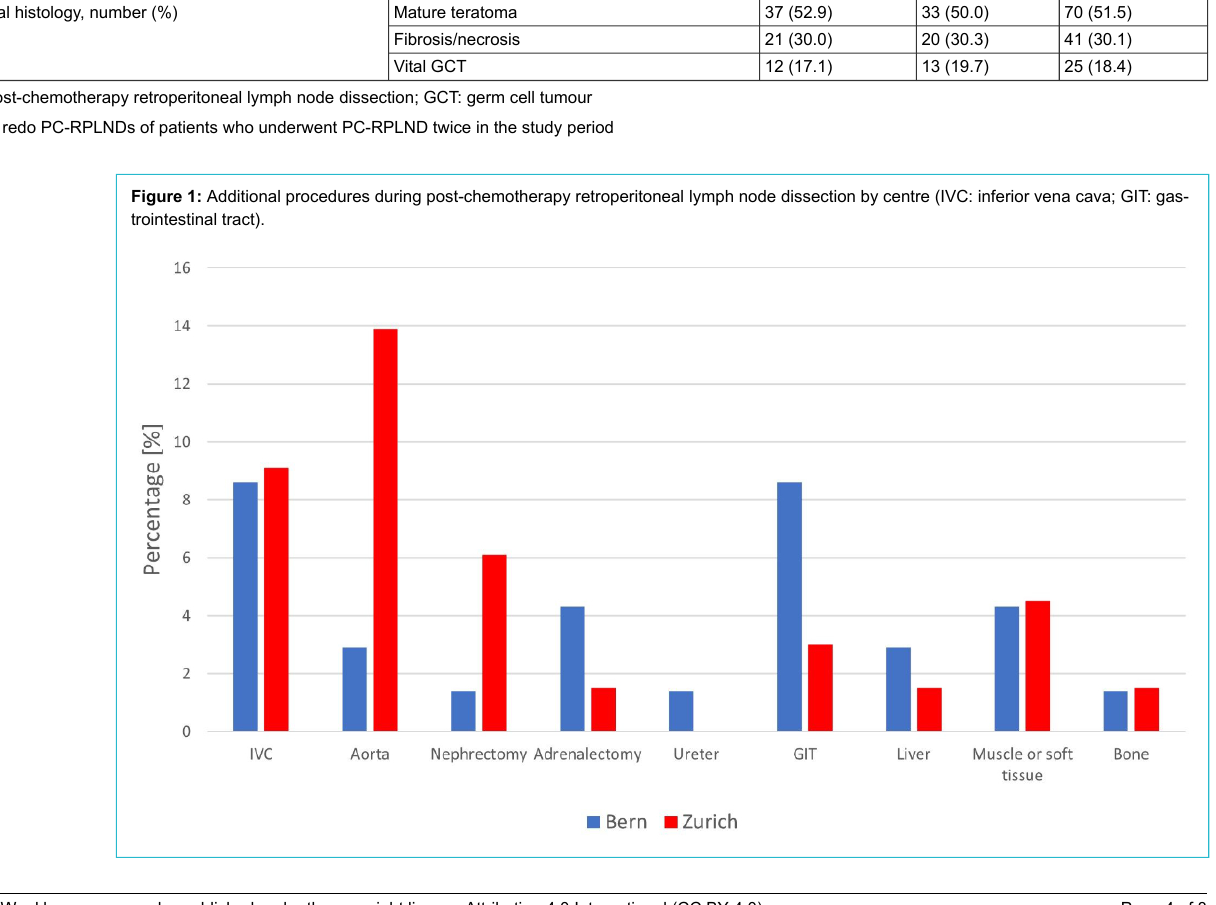
Modus of surgery, number (%) Open 69 (98.6) Operative time (minutes), median (range)